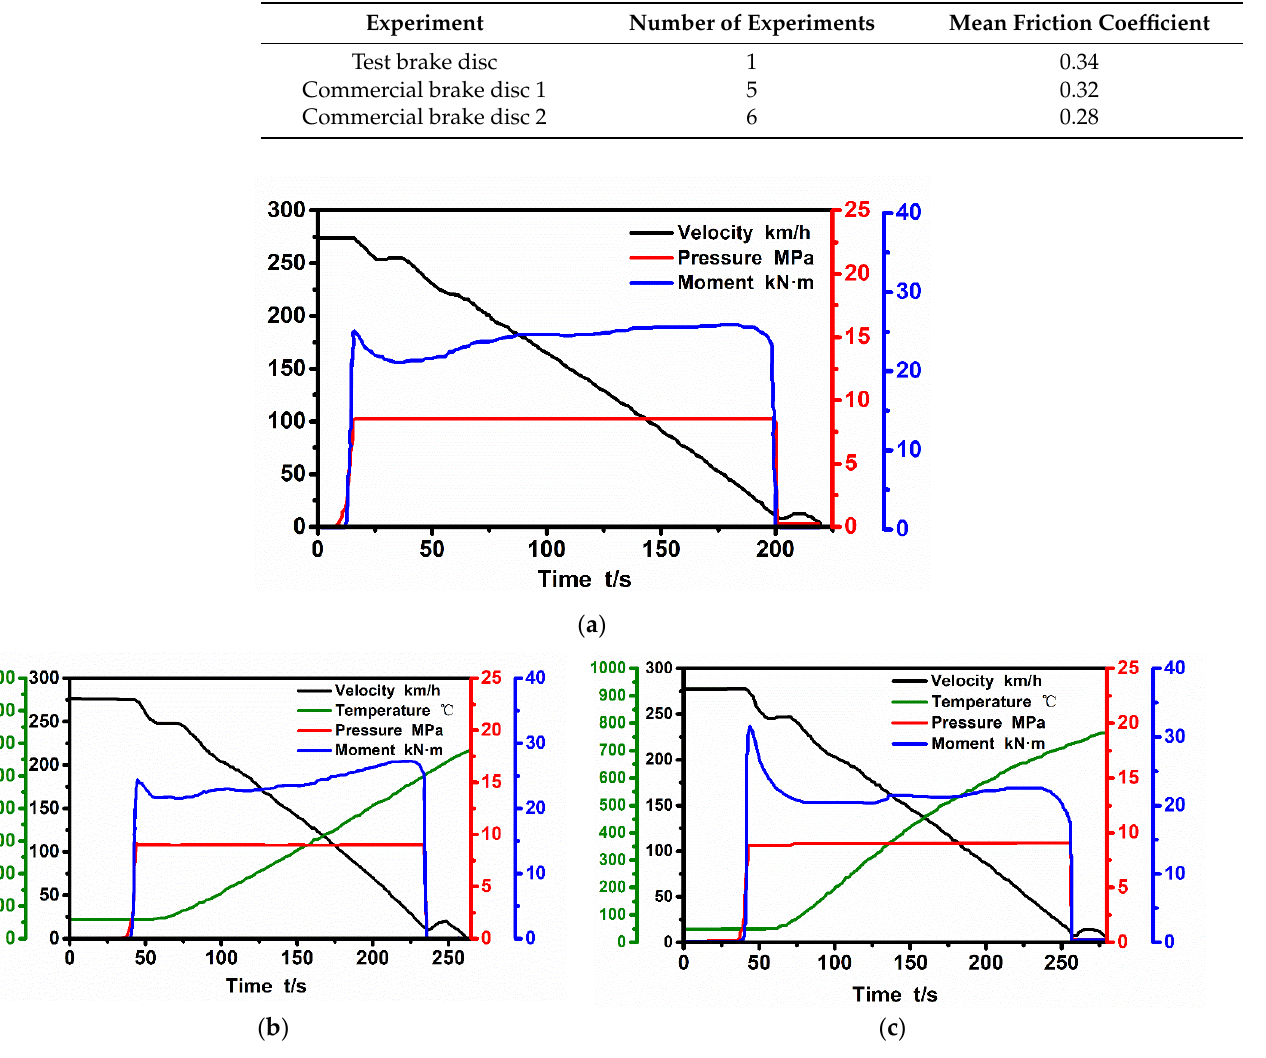
Figure 10. Typical braking curves of the three types of C/C brake discs in dynamic tests at an overload landing energy: ( a ) test brake disc; ( b ) commercial brake disc 1; ( c ) commercial brake disc 2.